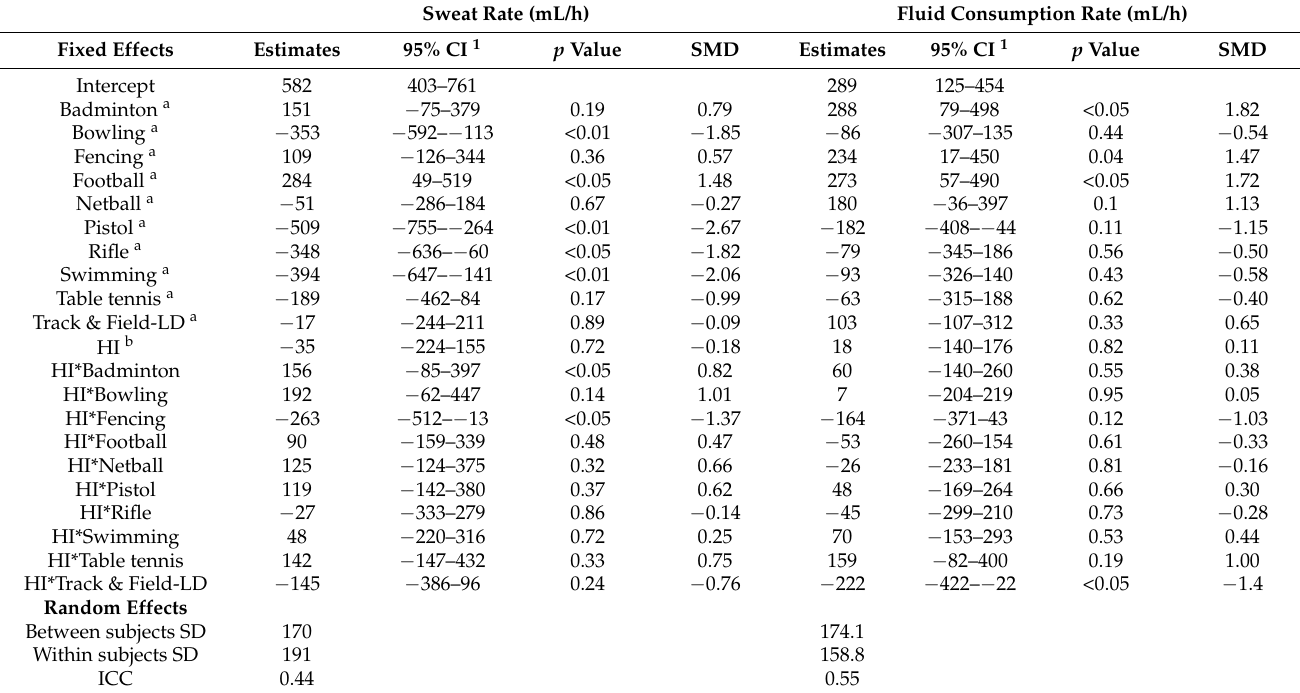
Table 3. Linear mixed model (sport x session intensity) interaction for sweat rate and fluid consumption